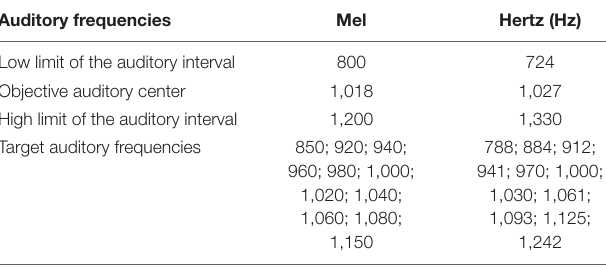
TABLE 1 | Conversion table of auditory frequencies used in the auditory interval bisection judgment. Auditory